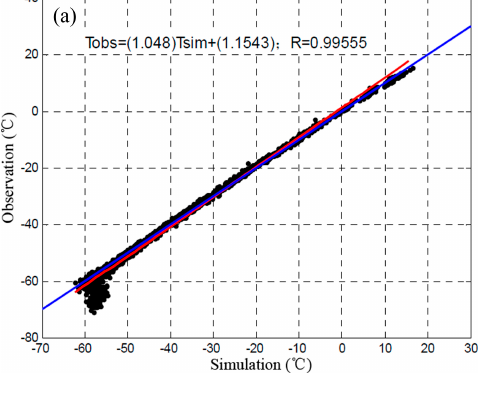
Table 3. Monthly runoff evaluation